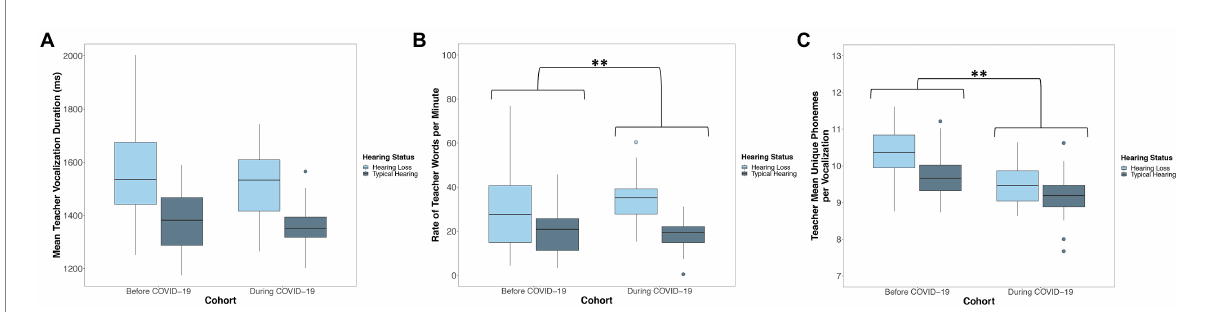
FIGURE 2 Distribution of the (A) mean duration, (B) word count rate per minute, and (C) phonemic diversity of children’s language input from teachers before (Cohort 1) and during COVID-19 (Cohort 2). Boxes represent the interquartile range, horizontal lines represent medians, whiskers represent error which is 1.5 times the interquartile range, and points outside of the boxes represent outliers outside of this range. Asterisks represent significant differences related to Cohort. * p < 0.05, ** p < 0.01. Children observed during COVID-19 (Cohort 2) were exposed to more teacher words per minute but less phonemically diverse teacher speech than children observed before COVID-19 (Cohort 1). Children with hearing loss were exposed to teacher vocalizations that were longer in duration, more teacher words per minute, and more phonemically diverse teacher